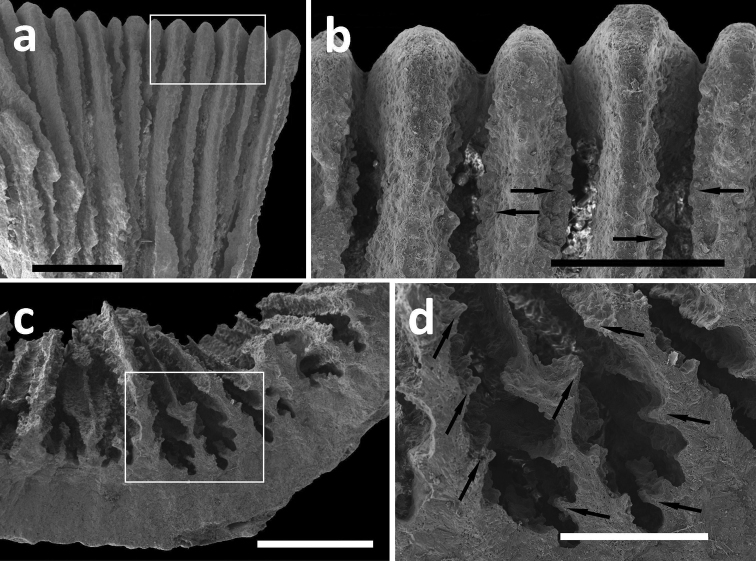
SEM photographs of Leptoseris troglodyta sp. n. from Wakatobi, Indonesia (RMNH Coel. 40152). a Upper side of septa showing wide menianes (scale bar: 1 mm; insert: Figure 5b) b Close-up (insert) of Figure 5a (arrows: menianes; scale bar: 0.5 mm) c Cross-section of septa showing multiple menianes along their sides (scale bar: 0.5 mm; insert: Figure 5d) d Close-up (insert) of Figure 5c (arrows: menianes; scale bar: 0.5 mm).